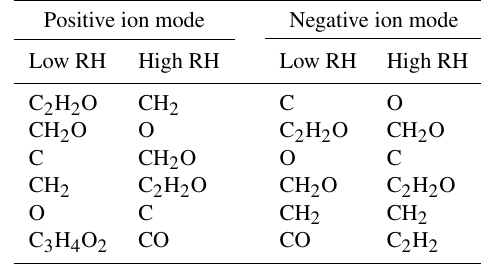
Table 3. Most common mass differences in the high-resolution mass spectra of low-NO x toluene SOA (in the order of decreasing frequency of occurrence). Positive ion